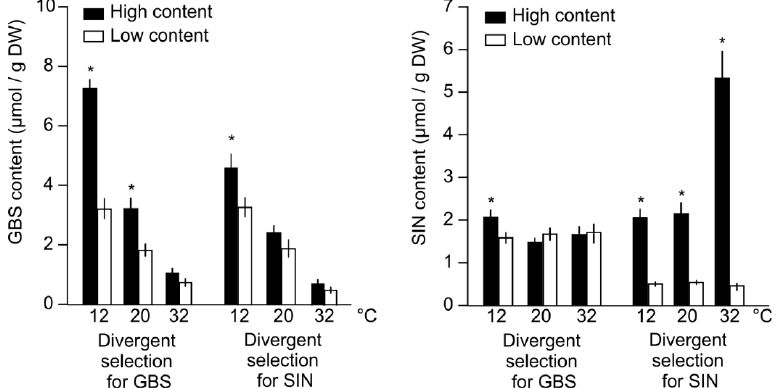
Figure 2. Glucobrassicin (GBS) and sinigrin (SIN) content in four kale populations from two divergent selections for glucosinolate content evaluated at control (20 °C), 12 and 32 °C. Error bars represent ± SE. Means with a * indicate significant differences between cold and control treatments within each population ( p ≤ 0.05, t -test).